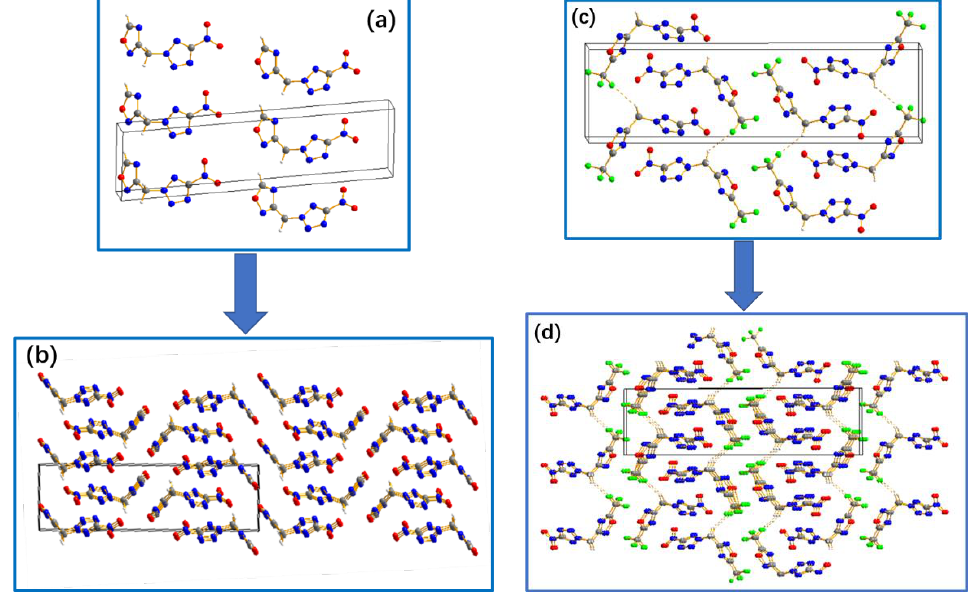
Figure 3. ( a ) Two-dimensional image of NTOM; ( b ) stacking diagram of NTOM; ( c ) two-dimensional image of NTOF; ( d ) stacking diagram of NTOF.